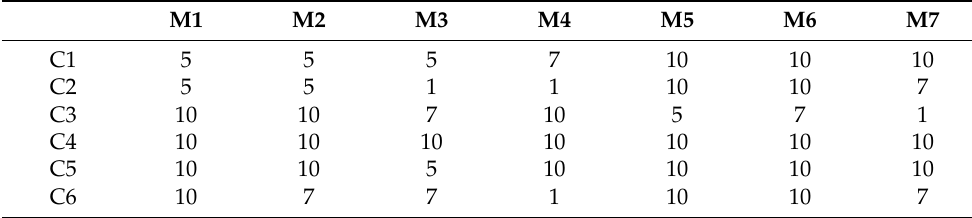
Table 19. DOMINIC numerical weighting